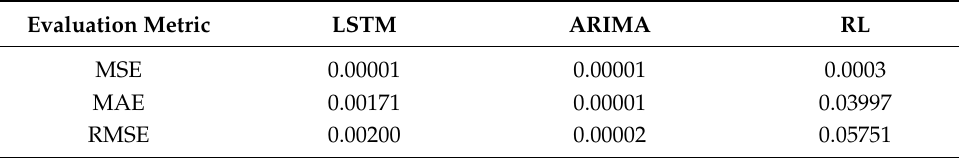
Table 7. MSE, MAE, and RMSE values for the predictive models